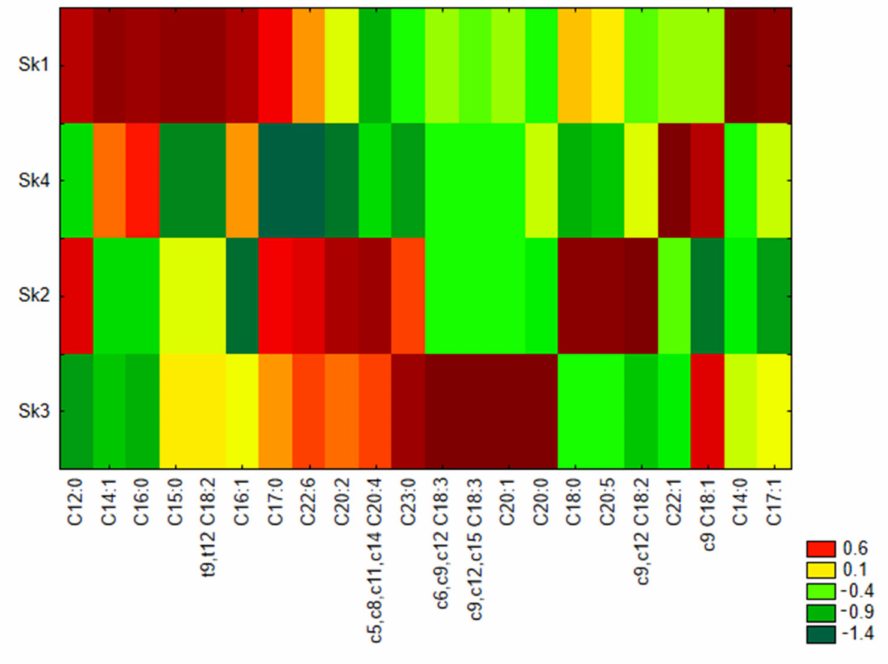
Figure 1. Heat maps of fatty acids mean percentage share in serum samples of distinguished clusters. Sk1–Sk4—clusters of serum samples revealed in cluster analysis.